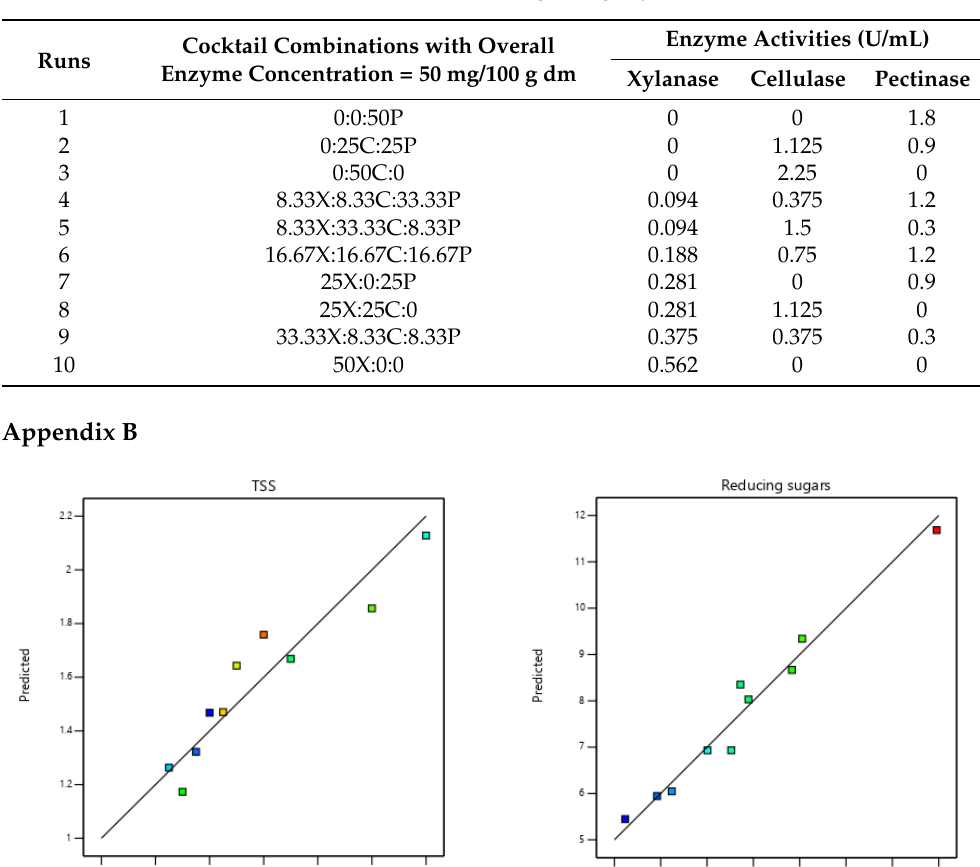
Table A1. Enzyme activities of xylanase, cellulase, and pectinase in different combinations of enzyme cocktail with an overall cocktail concentration of 50 mg/100 g dry matter.